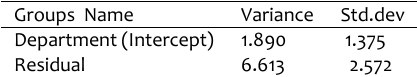
Table 7. Random Effects of the Second